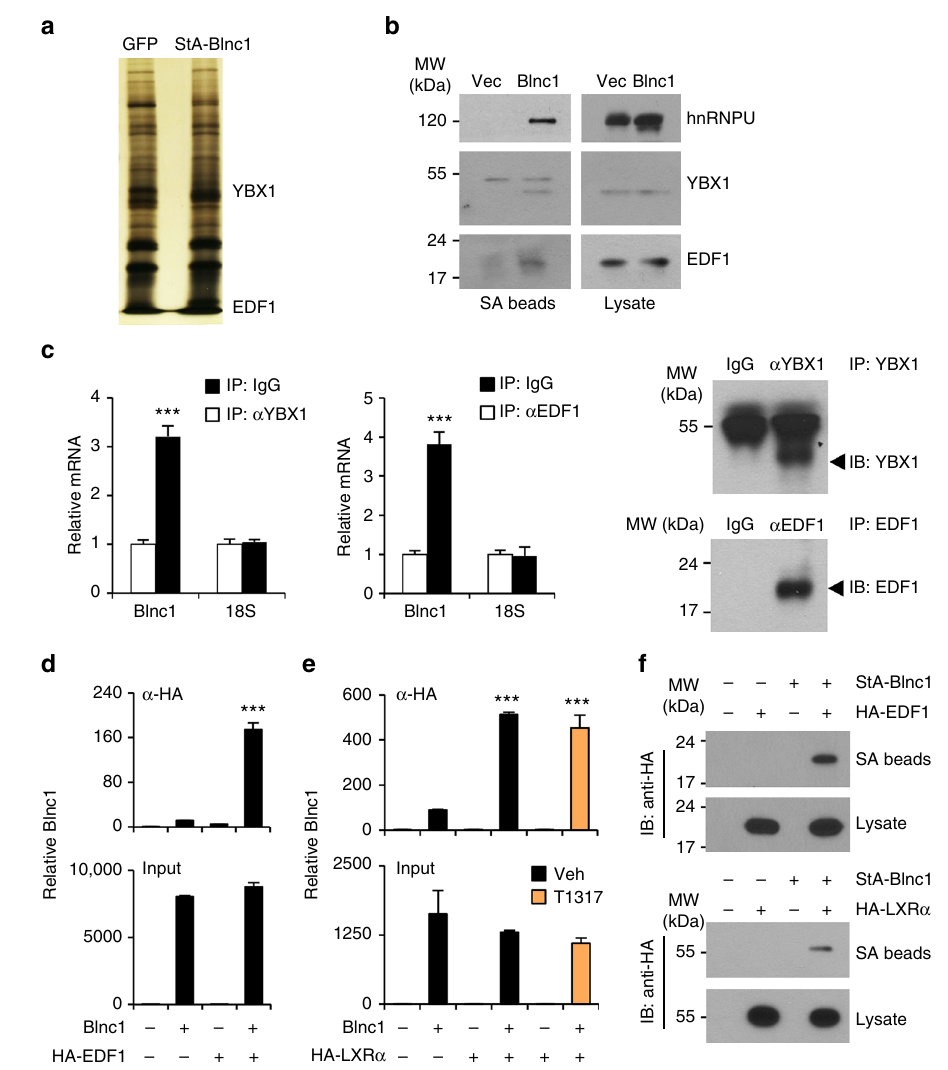
Fig. 8 Proteomic analysis of the liver Blnc1 ribonucleoprotein complex. a Silver-stained gel of af fi nity-puri fi ed Blnc1 complexes. b Immunoblots of precipitated proteins on streptavidin (SA) beads or total liver lysates. c IP/qPCR analyses of endogenous Blnc1 on the immunocomplexes as indicated. Immunoblots of precipitated proteins are shown on the right. Data represent mean ± SD ( n = 3). *** p < 0.001, two-tailed unpaired Student ’ s t -test. d IP/qPCR analyses of Blnc1 in EDF1 ( d ) or LXR α ( e ) immunocomplexes (top) or input (bottom) from transiently transfected HEK293T cells. Data in ( d ) and ( e ) represent mean ± SD ( n = 3). *** p < 0.001, two-way ANOVA. f Immunoblots of HA-EDF1 (top) or HA-LXR α (bottom) from total lysates